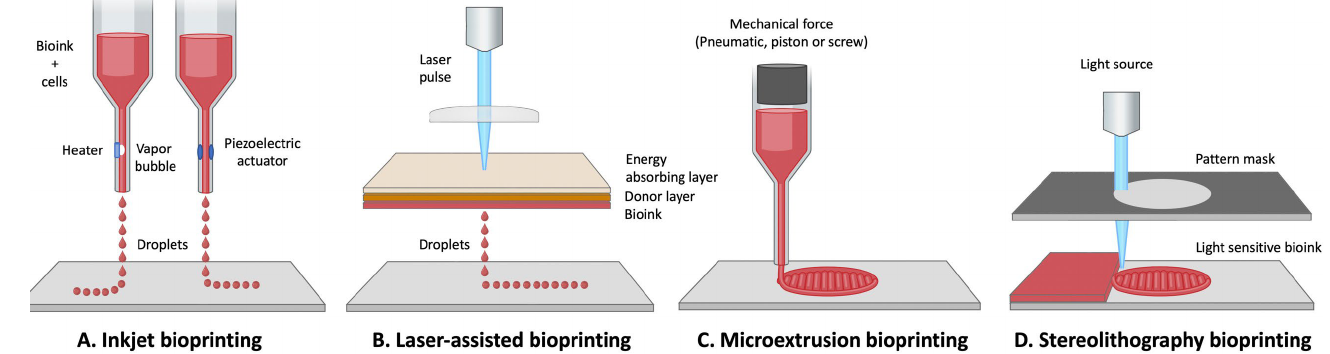
Figure 3. Common bioprinting techniques used to prepare tissues. Inkjet bioprinters controlled by thermal or piezoelectric forces deposit small droplets of bioink and cells to build tissues layer-by- layer ( A ). Laser-assisted bioprinting uses a laser absorbed by an energy absorber layer to heat a donor layer, which forms a bubble propelling the bioink and cells onto the substrate ( B ). Microextrusion bioprinters deposit a cell-laden bioink solution via pneumatic, piston, or screw mechanical force ( C ). Stereolithography bioprinters use UV or visible light to selectively cross-link light-sensitive bioinks layer-by-layer to build a 3D tissue ( D ). Figure produced with